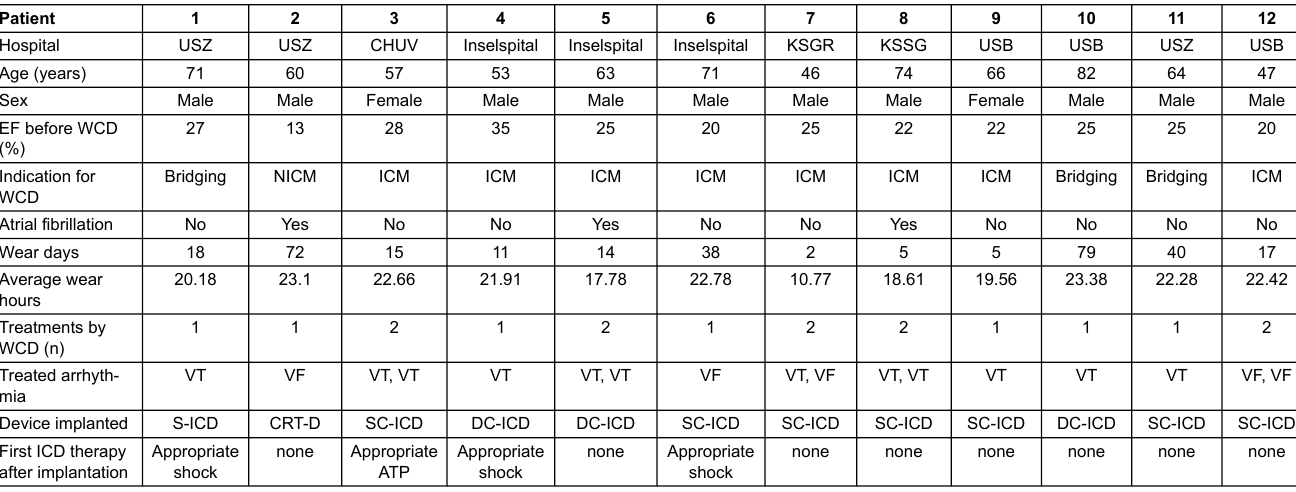
Table 3: Patients with treatments by the wearable cardioverter defibrillator.